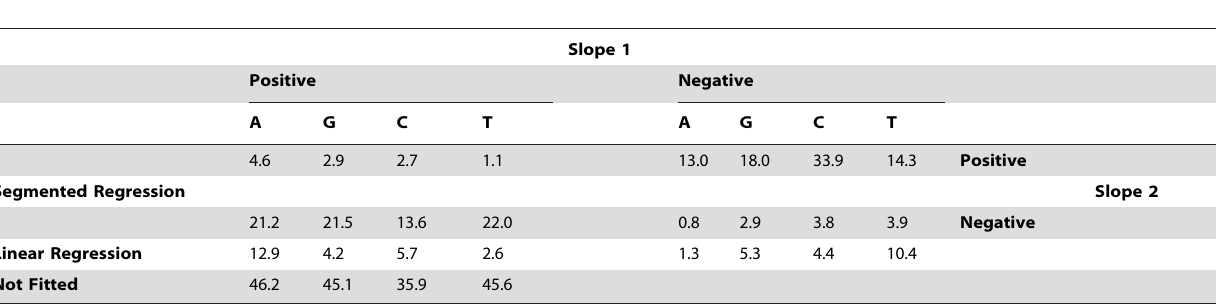
Table 2. Percentages of the Arabidopsis coding sequences that significantly fitted the segmented regression and the linear models.